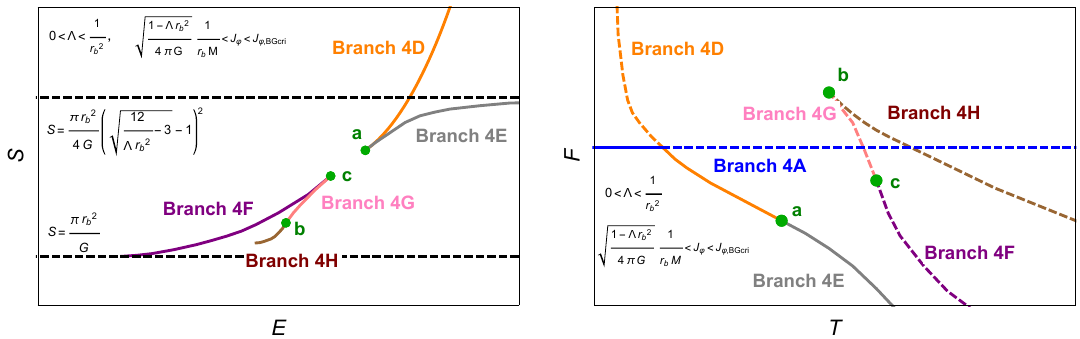
Figure 21 . Qualitative behaviors of entropies (left panel) and free energies (right panel) of BG instanton (and Euclidean soliton) when 0 < Λ < 1 modynamically stable branches are 4A, 4E, and 4G; the others are unstable. As we increase J points a , b , and c become close and coincide when J Above that value, the branches are reconnected as in figure 22. ( Left ) The dominant saddles are 4F and 4D. There is no entropy bound. ( Right ) Although some temperature regions are dominated by thermodynamically stable branches 4A and 4E, they suffer from quantum tunneling instability. Therefore, the system is thermodynamically